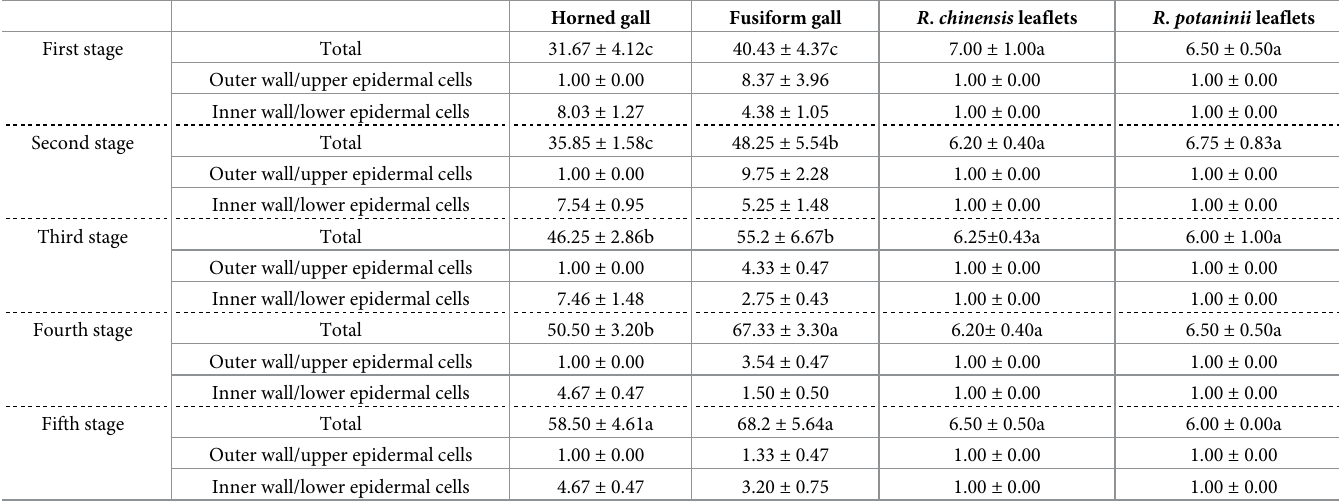
Table 2. Number of cell layer among four kinds of tissue at different stages.